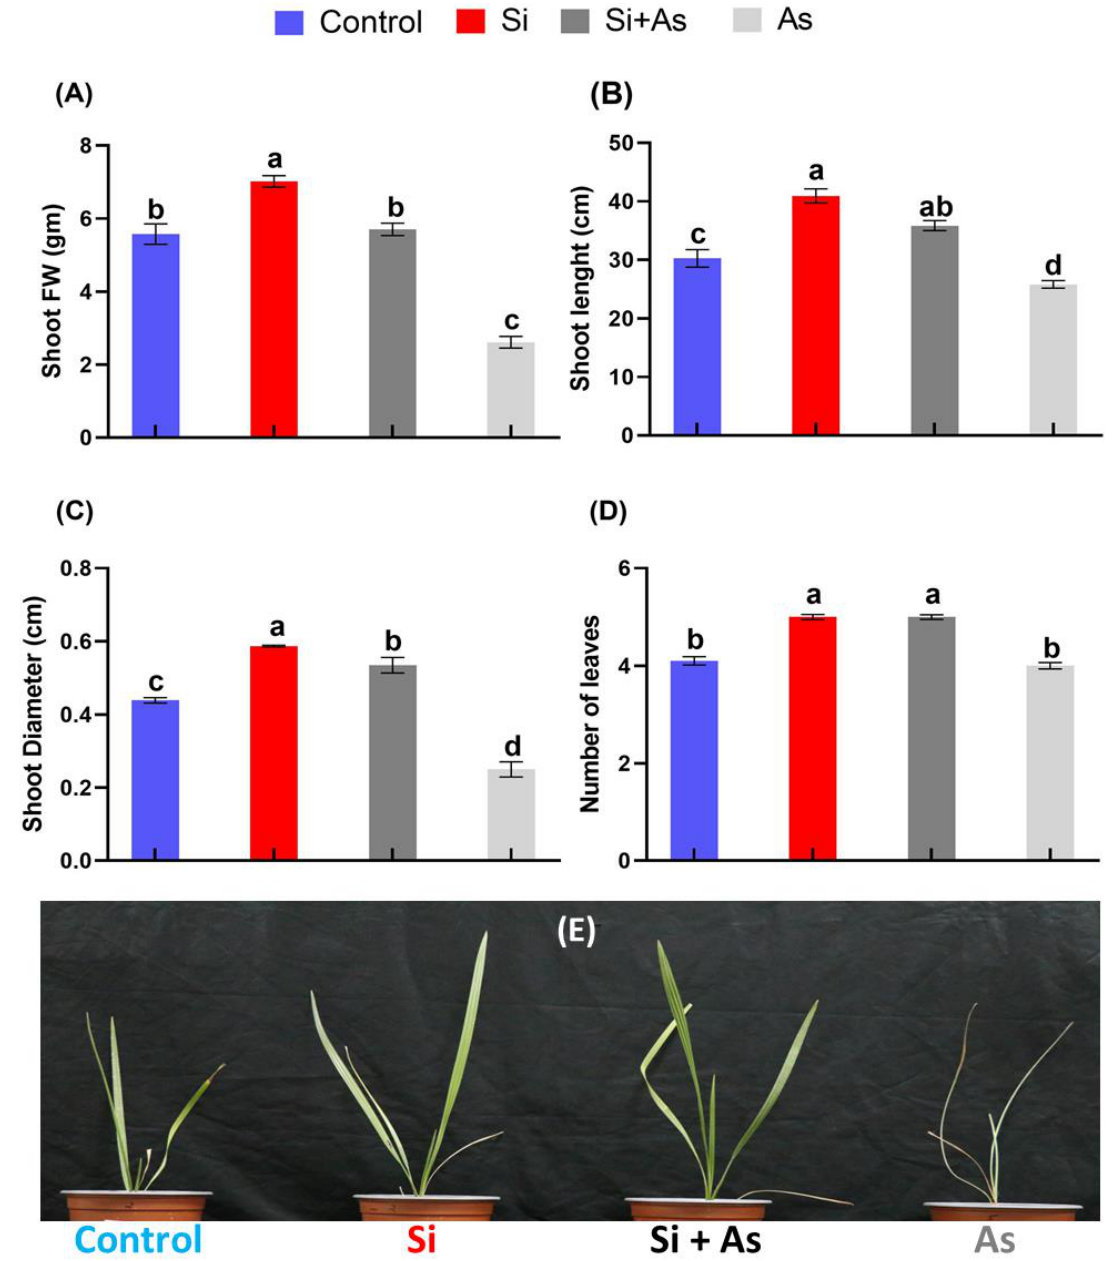
Figure 1. Morphological and physiological variations induced by heavy metal stress alone or in combination, in date palm. ( A ) Shoot fresh weight, (B ) shoot length, ( C ) shoot diameter, and ( D ) number of leaves. ( E ) Date palm seedlings picture. Different letters indicate the values are significantly different (p < 0.05). Means were analyzed for finding the significant differences among treatments by using Duncan’s multiple range test (DMRT). Values represent means (of 7 replicates) ± standard error.